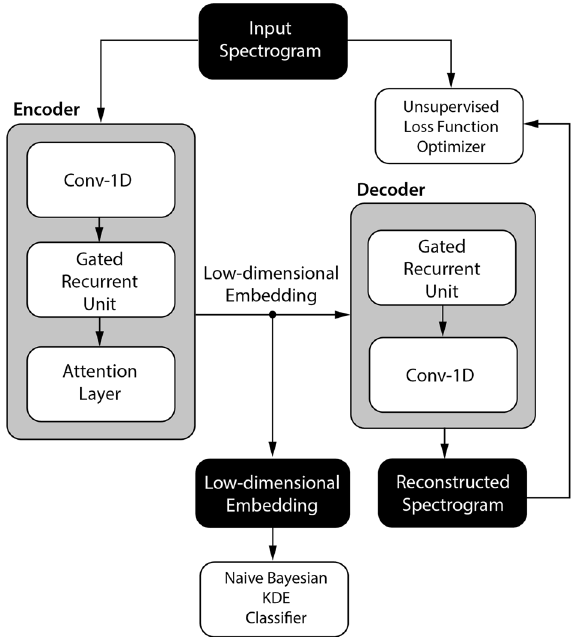
Figure 3. Neural network encoder-decoder architecture. The figure shows a block diagram of neural network encoder-decoder architecture utilizing an attention mechanism for unsupervised iEEG feature extraction. Input consists of iEEG data spectrograms propagated through gated recurrent units (GRU) encoder providing low-dimensional embedding space. Subsequently, the GRU decoder reconstructs the input spectrograms while minimizing the unsupervised loss function (mean square